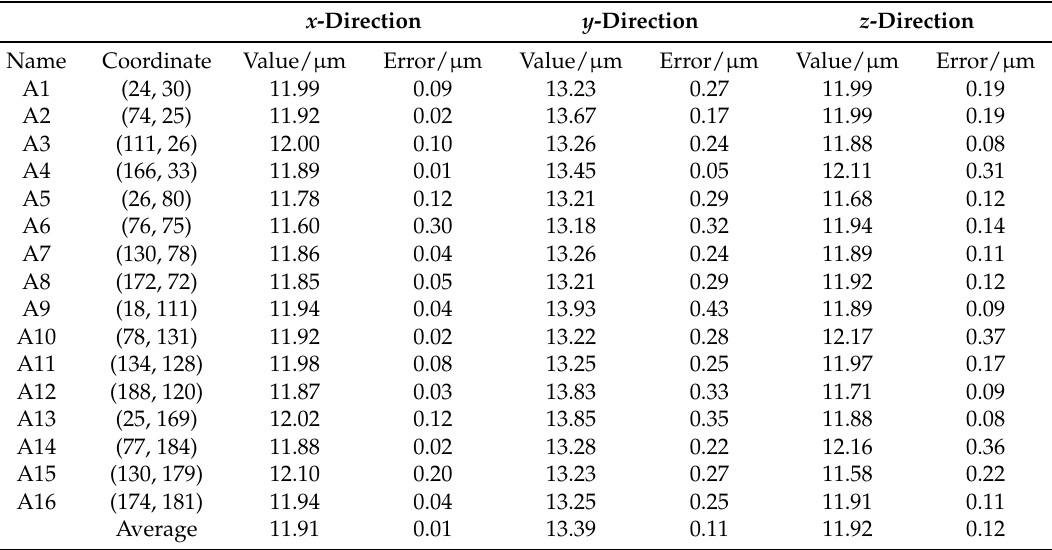
Table 1. The measured results of sixteen detection